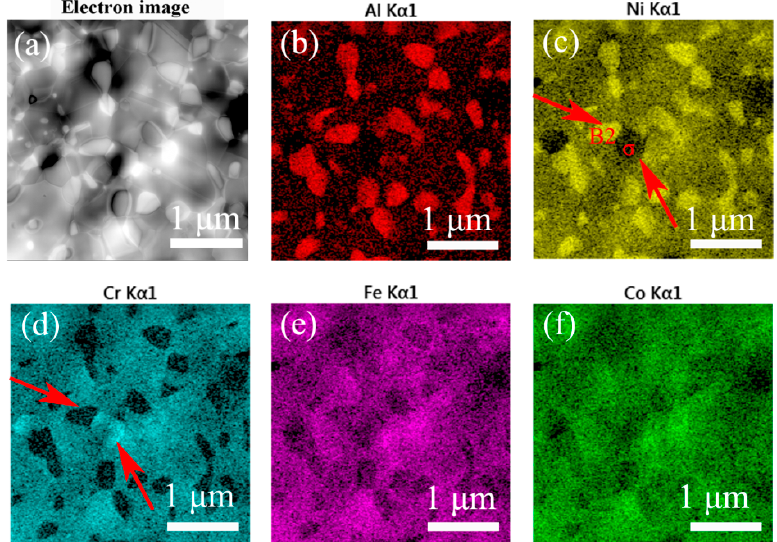
Figure 6. ( a ) STEM images in AR800 sample and corresponding elemental mapping of ( b ) Al, ( c ) Ni, ( d ) Cr, ( e ) Fe, ( f ) Co.